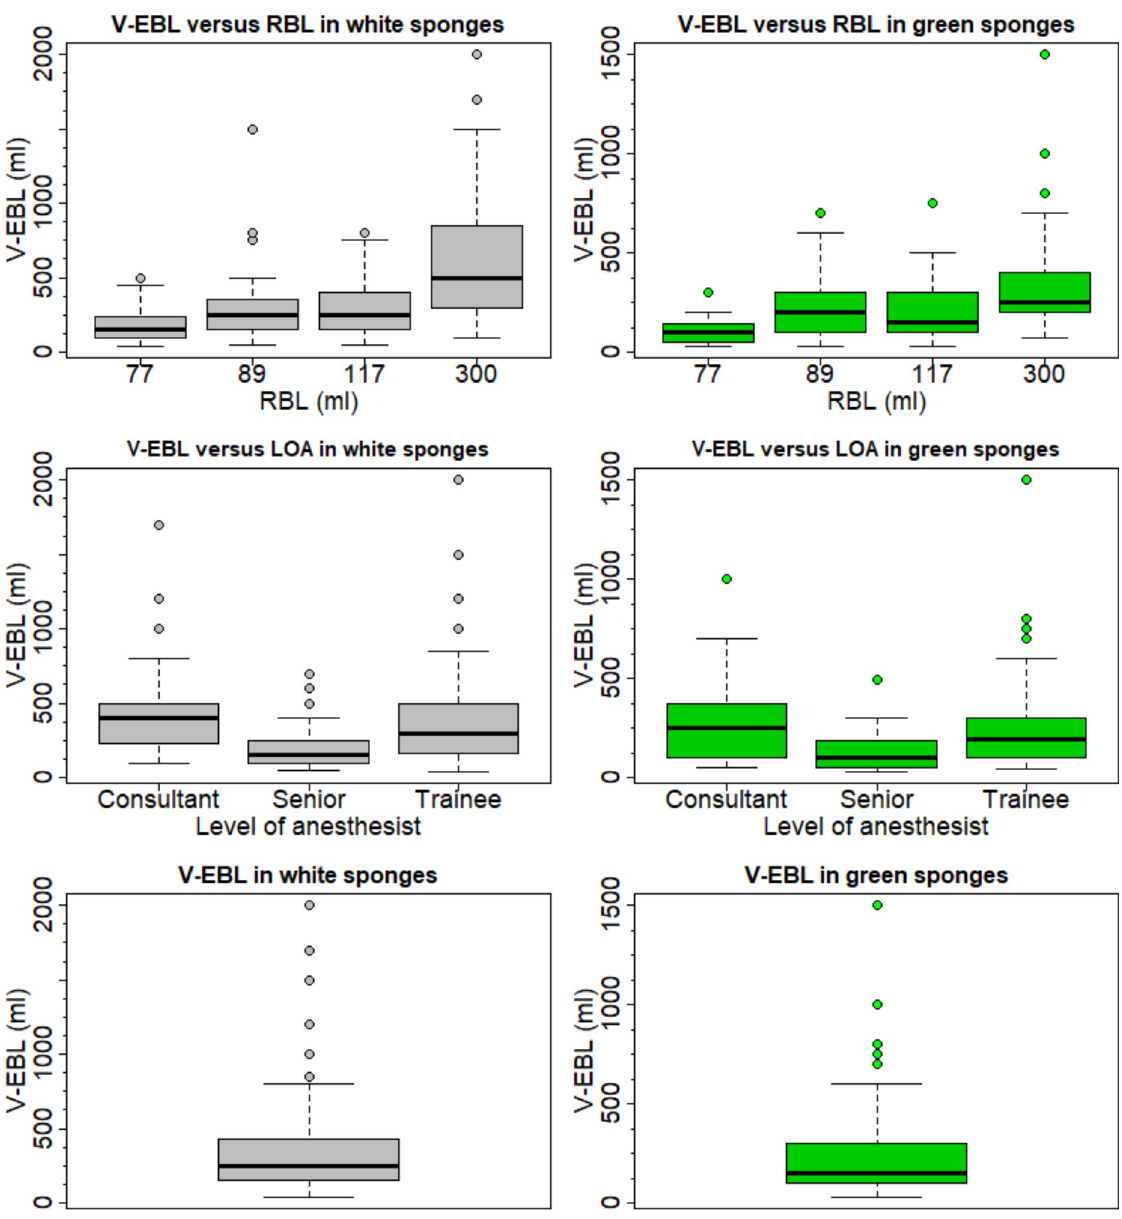
Fig 1. Boxplots for visual blood loss estimation in white and green sponges. Fig 1 demonstrates the visually estimated blood loss (V-EBL) for white and green sponges and the deviation from the reference blood loss (RBL) per scenario, estimates by qualification level (LOA Level of anaesthetist) and total estimates by green and white